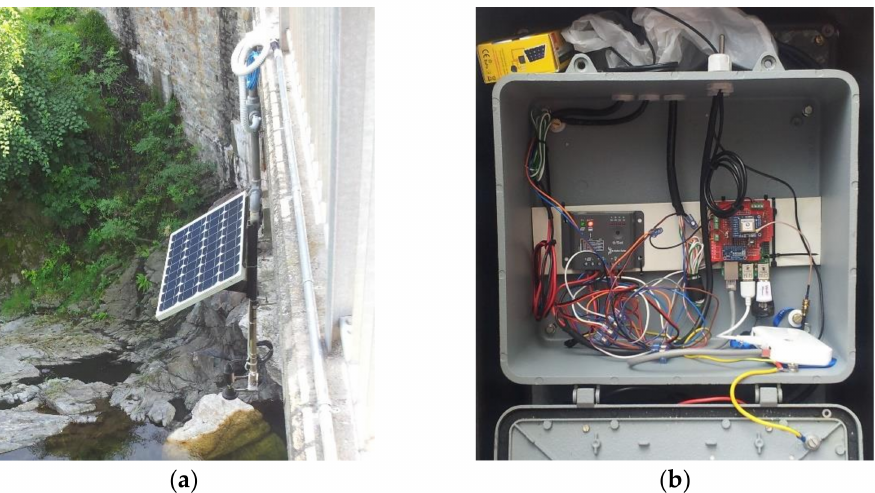
Figure 2. Hydrological station on River Cannobino: ( a ) hydrological sensor and solar panel; ( b ) detail of the contents of the shell: modem and various electronic elements.